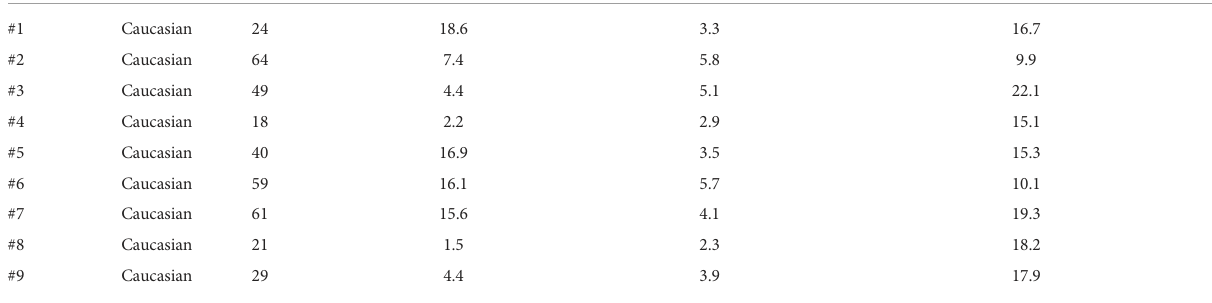
TABLE 1 Clinical features of LCTs